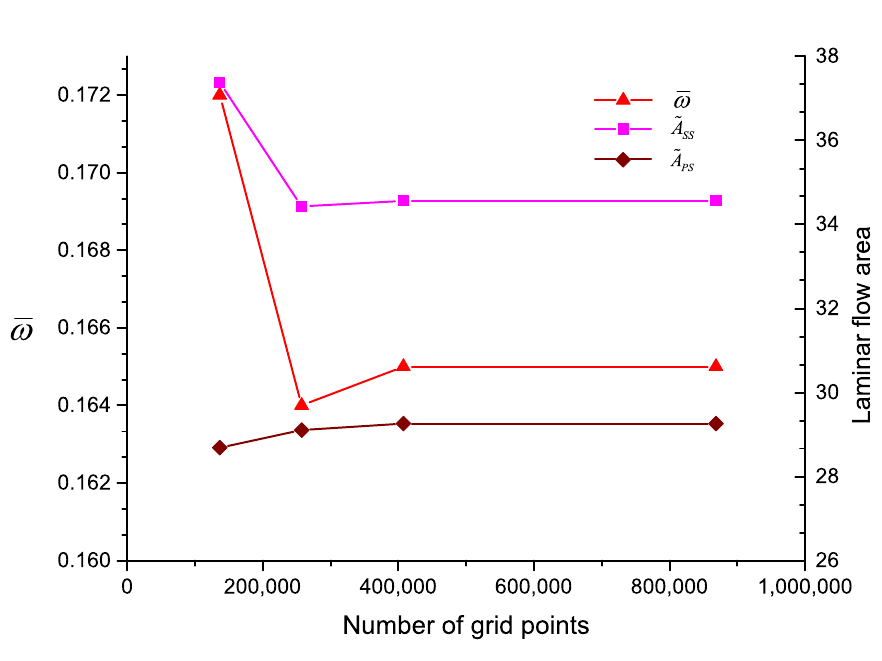
Figure 11. Computation results at different number of grid